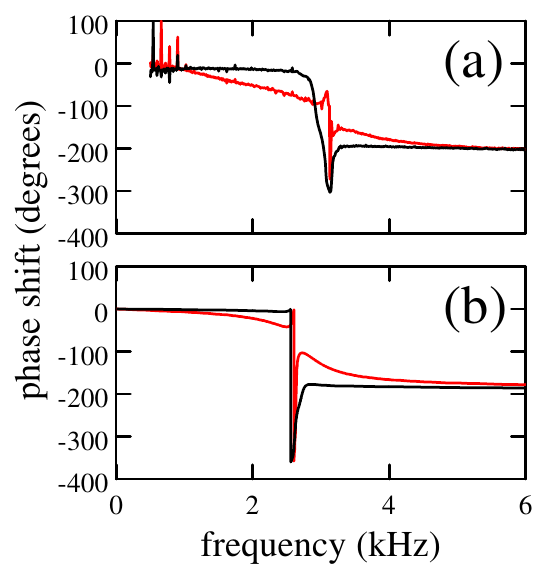
FIG. 8. (Color) Operation with optimal bunch lengthening, where a fast mode-coupling Robinson instability increases the beam’s phase noise and energy spread. Black curves: phase feedback off. Red curves: phase feedback on. (a) Experimental measurement of the transfer function phase shift. (b) Phase shift calculated with the beam energy spread equaling its natural